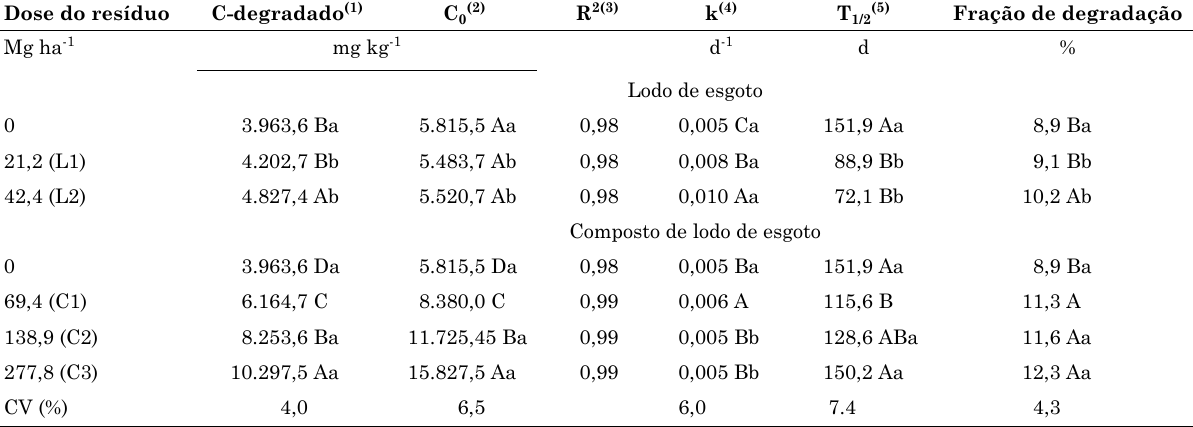
(1) C-degradado: quantidade de carbono liberado acumulado na forma de CO mineralizável em 241 dias de incubação; (3) R 2 : coeficiente de correlação do modelo de Stanford e Smith (1972); (4) k d -1 : taxa de decomposição por dia; (5) T 1/2 : tempo de meia-vida. Médias seguidas pelas mesmas letras minúsculas, entre as mesmas doses de lodo e compostos, não diferem entre si (Tukey a 5 %). Médias seguidas pelas mesmas letras maiúsculas para as doses dentro de cada resíduo não diferem entre si (Tukey a 5 %).